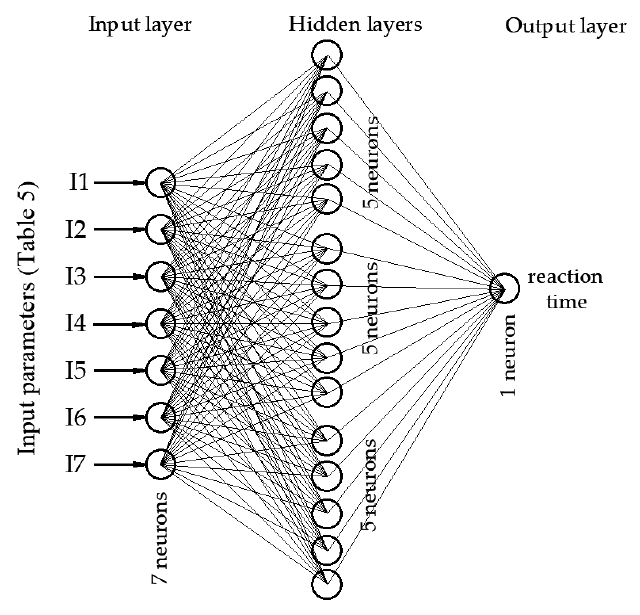
Figure 3. Neural network configuration.